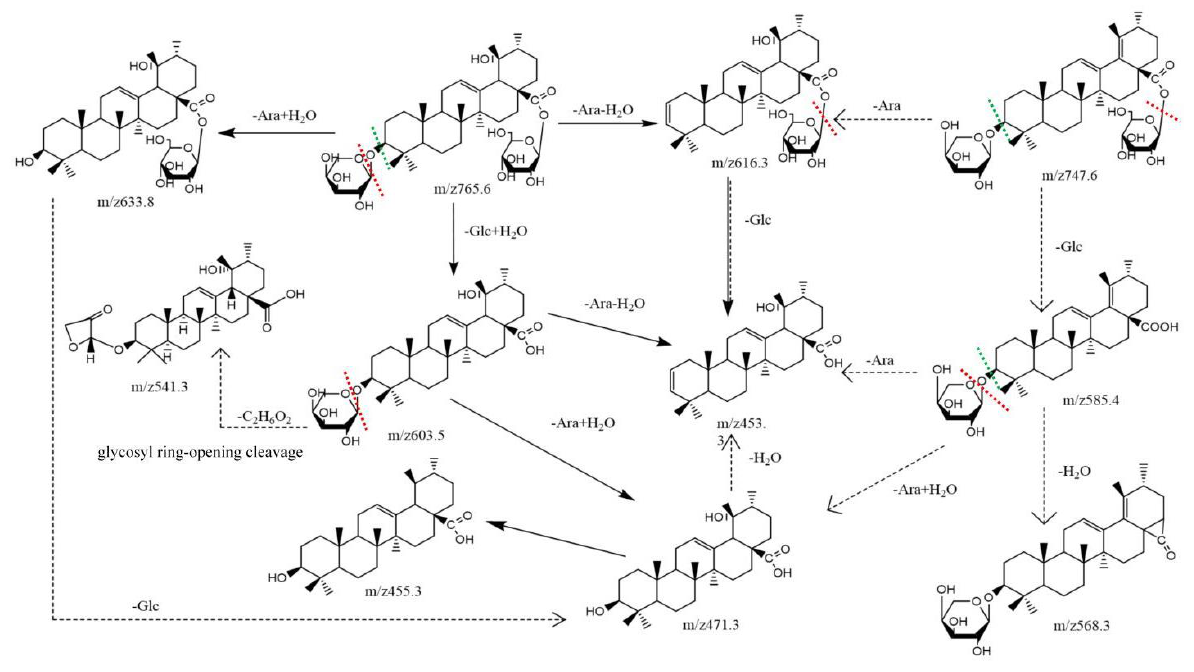
Figure 7. The possible transformation process in Sanguisorba officinalis L. under processing.